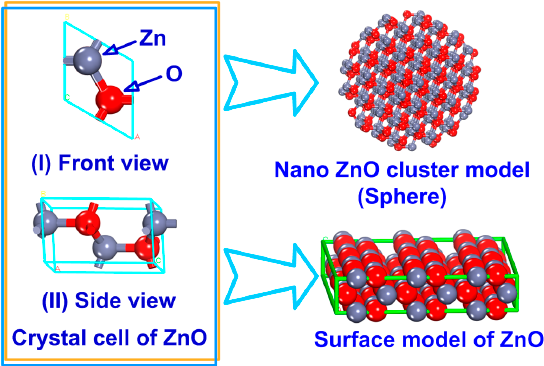
Figure 14. Molecular structure of nano-ZnO.